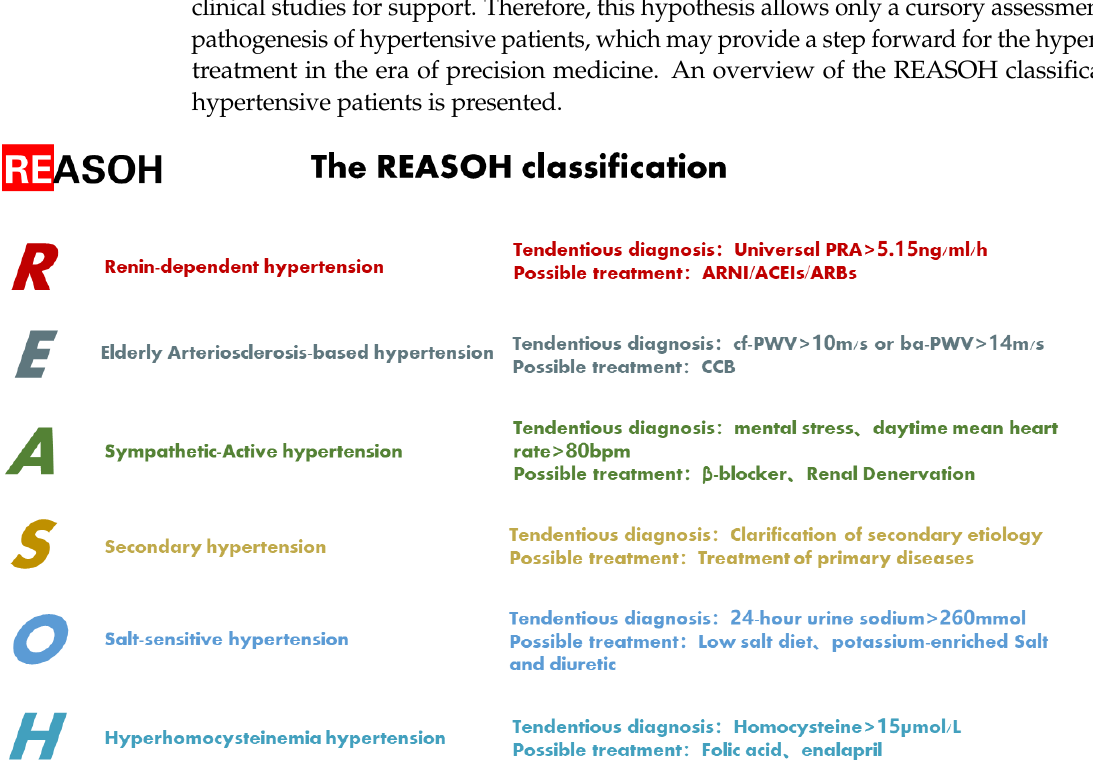
Figure 1. The REASOH classification: a hypothesis about etiological diagnosis and personalized therapy for hypertension. ACEIs: angiotensin-converting enzyme inhibitors; ARBs: angiotensin-receptor blockers; ARNI: angiotensin receptor blocker and neprilysin inhibitor; ba-PWV: brachial-ankle pulse wave velocity; CCB: calcium channel blocker; cf-PWV: carotid-femoral pulse wave velocity; PRA: plasma renin activity.